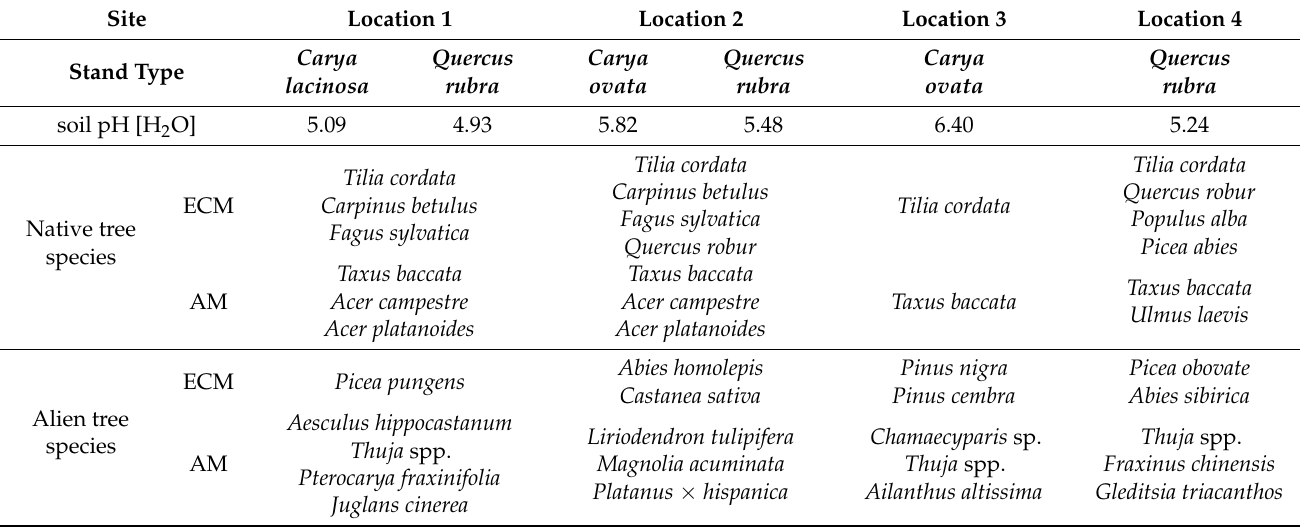
Figure 1. Study stands ( a ) and the distance between locations 1–4 ( b ). Table 1. Tree composition in the surrounding area of tested tree species (Ø 50 m).